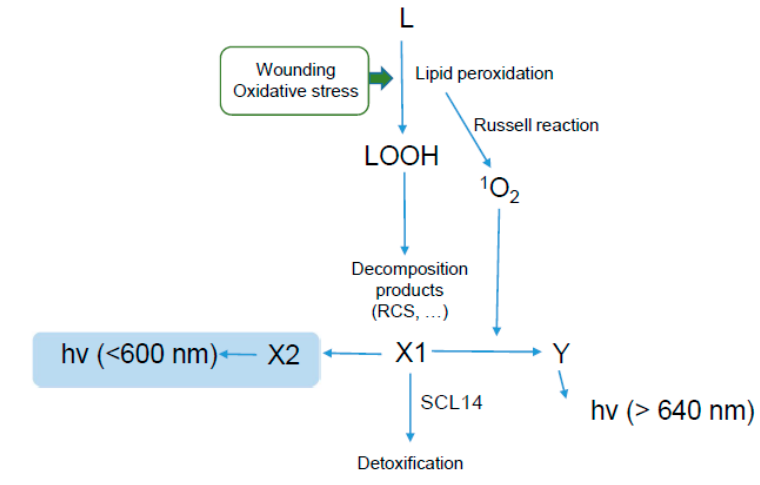
Figure 12. Working model for the origin of SCL emission by plant tissues. Hydroperoxides (LOOH) produced in lipid (L) peroxidation decompose in secondary products symbolized by X1. Reaction between X1 or derived metabolites and singlet oxygen generate species (Y) that luminesce > 640 nm. Those luminescent compounds have a rather long lifetime, regulated by the SCL14-dependent detoxification pathway. X1 can lead to X2 (without excluding the possibly that it occurs through Y). X2 or derived metabolites emit photons < 600 nm; they accumulate in vitro (highlighted in blue), not in planta.